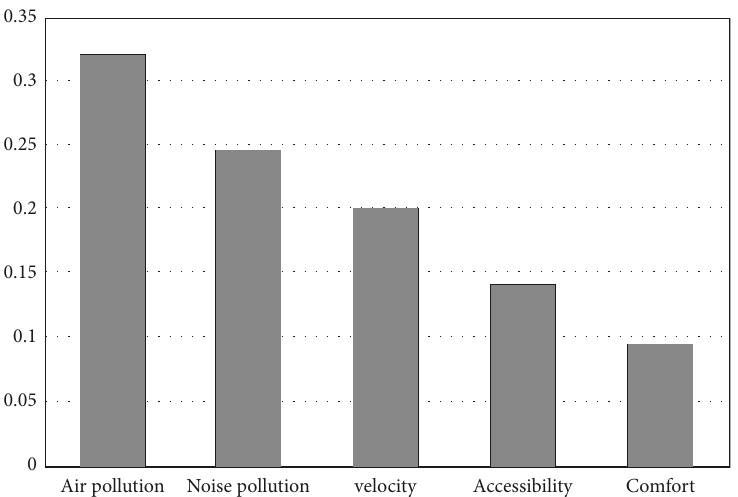
Figure 4: Prioritization of different criteria.